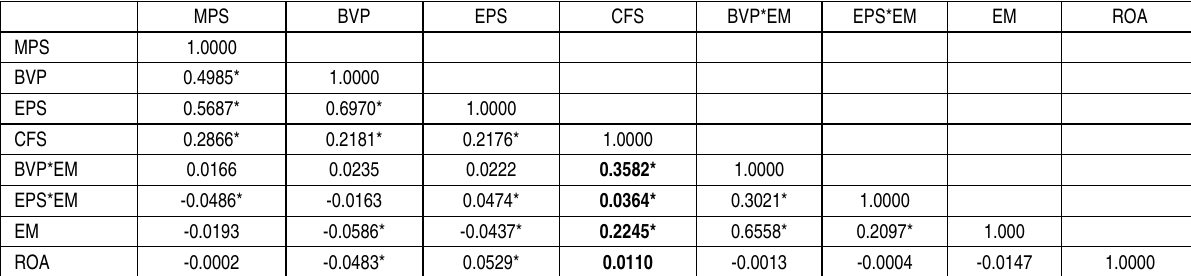
Table 3. Pearson correlation matrix for the variables